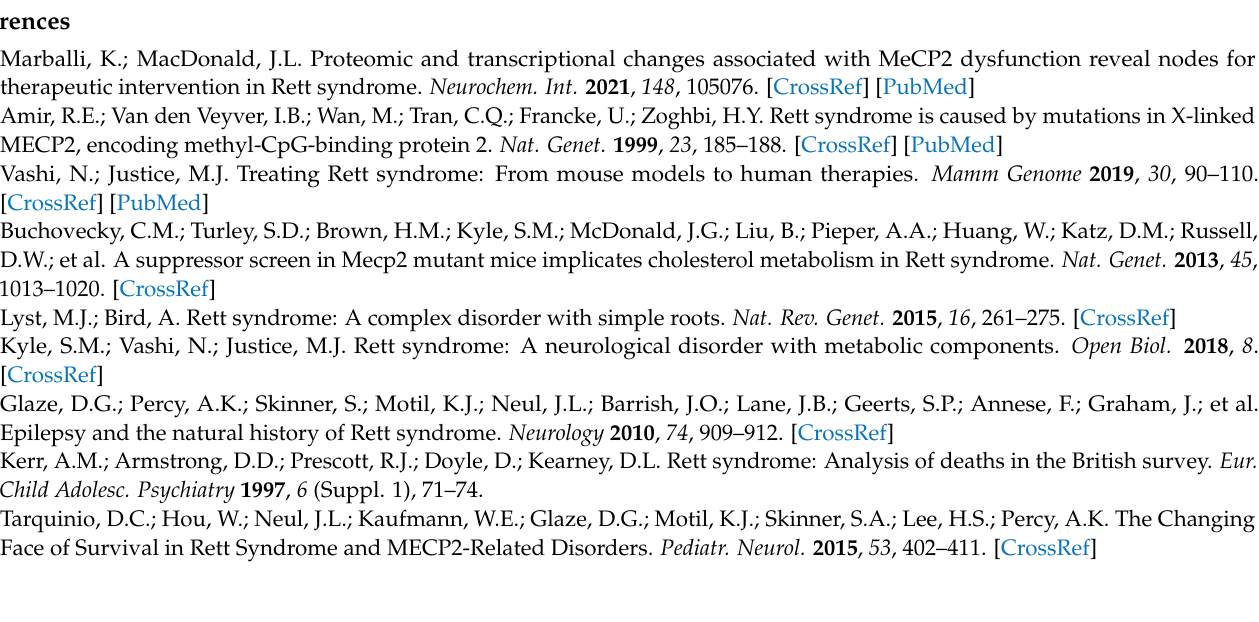
and Observation Diagnostics. Table S1: Clinical Parameters of RTT Patient Study Cohort, Table S2: Loading Plot of CSF Samples, Table S3: Loading Plot of Plasma Samples, Table S4: Wilcoxon Rank-Sum Test of Lipid Classes Detected in CSF Samples, Table S5: VIP Plot of CSF